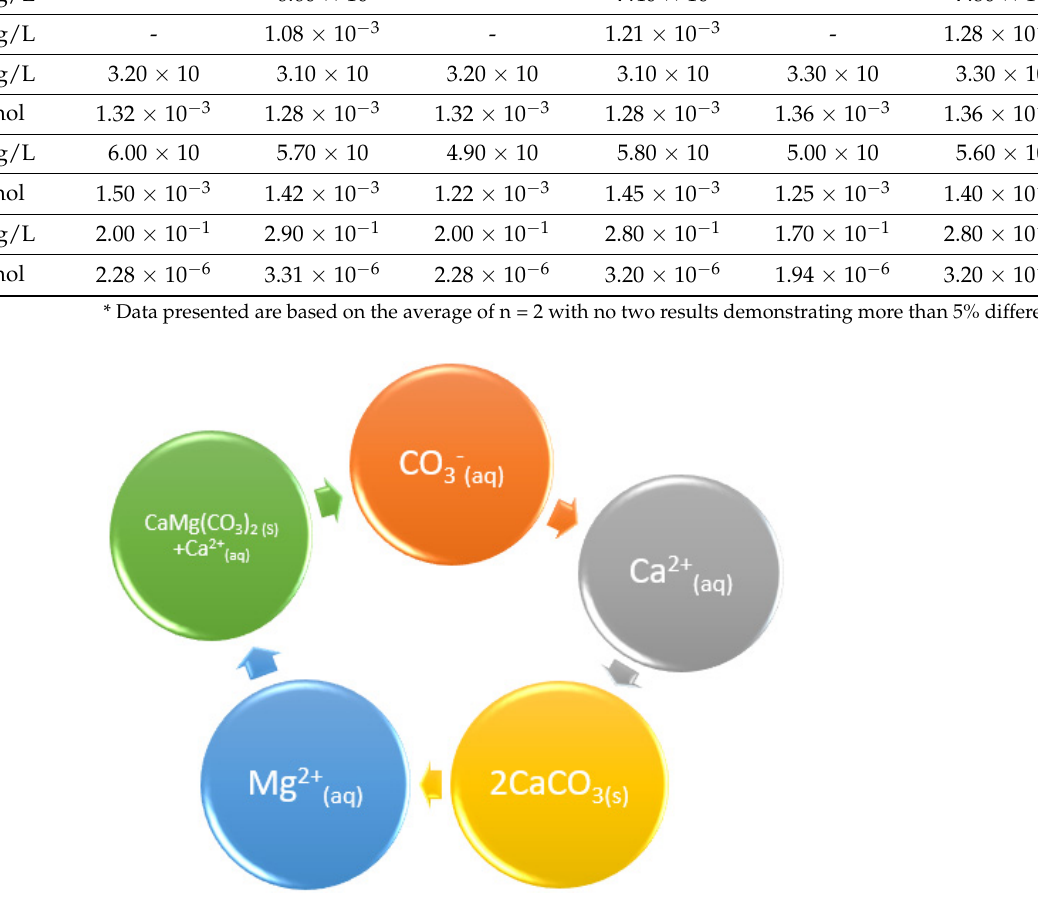
Table 1. Mineral concentrations * over time in experimental solutions of water containing naturally occurring strontium in contact with three pyrolusite media conditions, including untreated, coated with humic acid (HA), and coated with fulvic acid (FA).